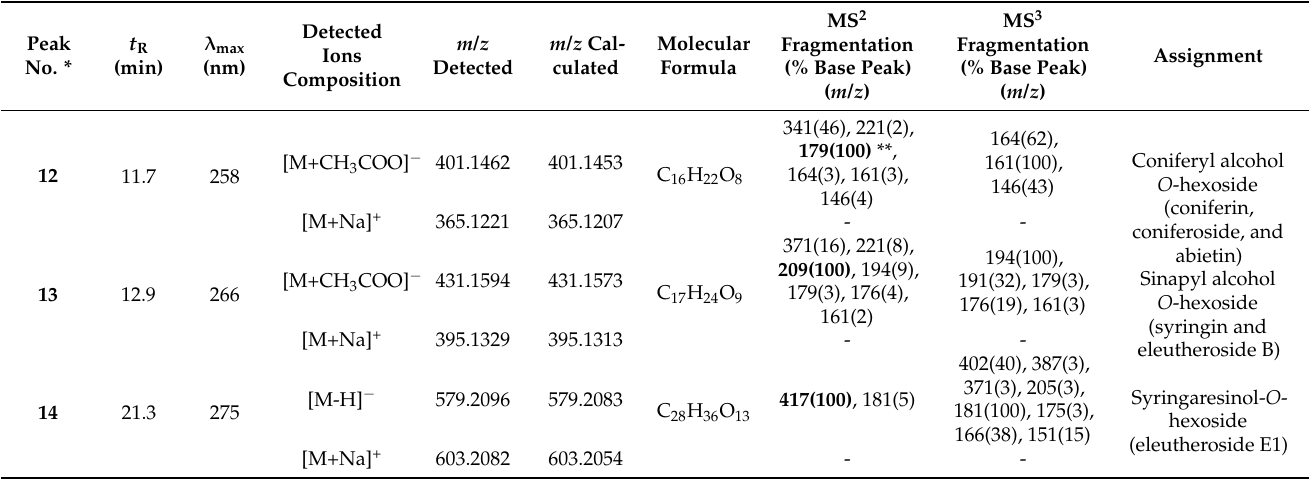
Table 3. List of lignol derivatives identified in the methanol extracts of Sr-L1 callus culture of S. radiata by their retention times, UV and MS data, and by comparison with published